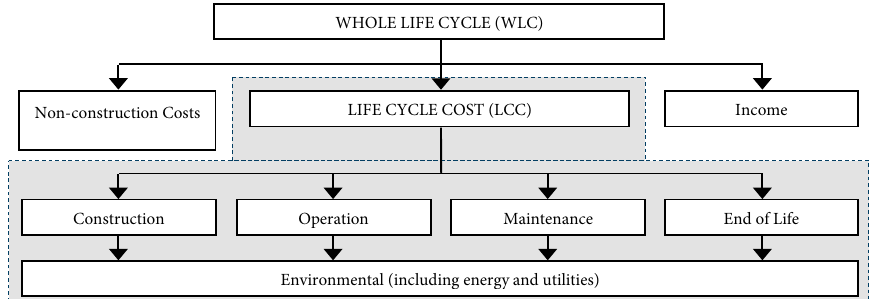
Figure 1. Elements of whole life cycle ( WLC ) and life cycle cost ( LCC ) (source: own study based on standard drawing 2, ISO, 2008)